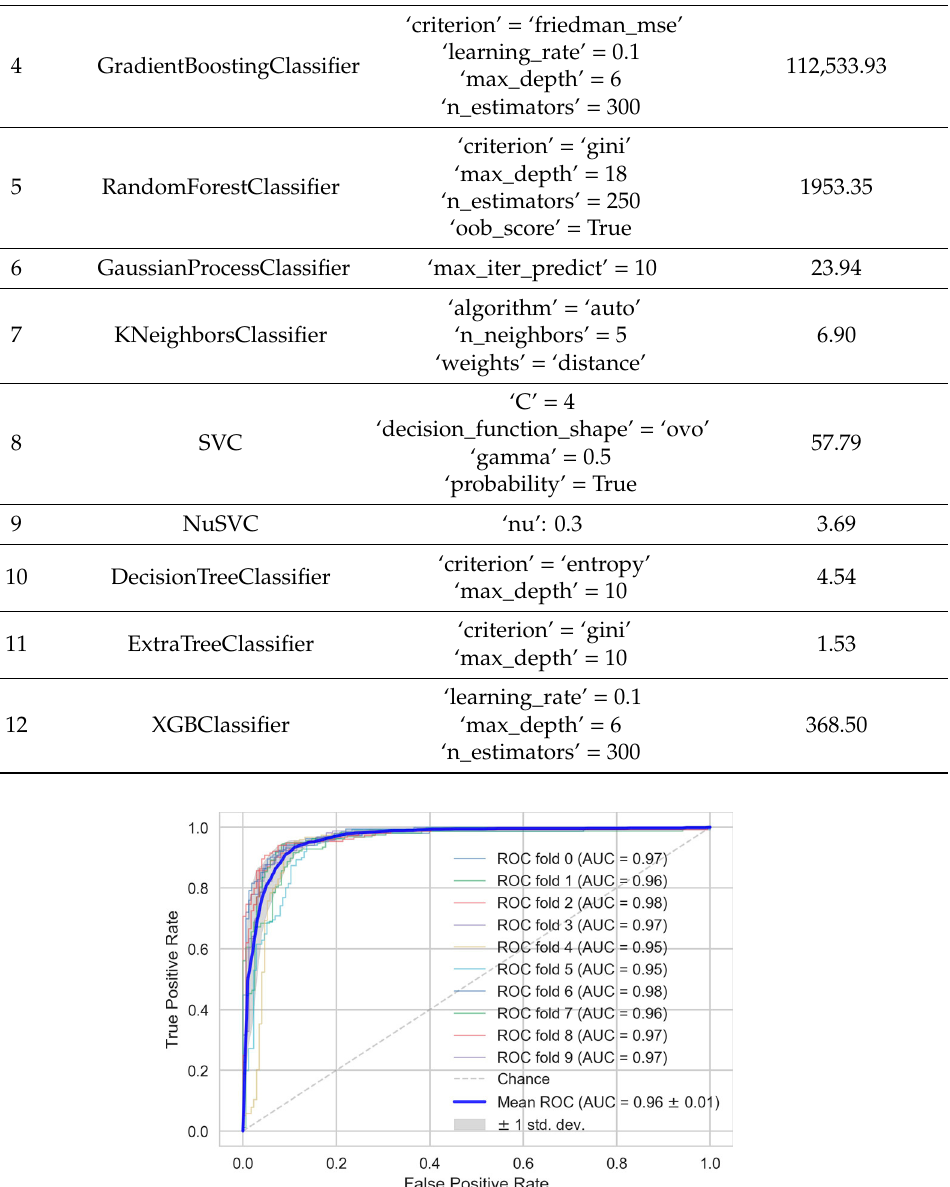
Figure10. Receiver Operating Characteristic Curve (ROC) and AUC of SVC using 10-fold Figure 10. Receiver Operating Characteristic Curve ( ROC) and AUC of SVC using 10-fold cross- validation.